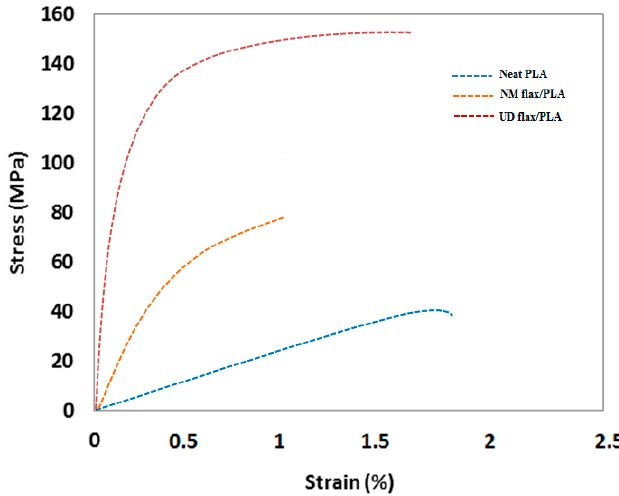
Figure 3. Tensile stress-strain curves of neat PLA and flax/PLA composites.